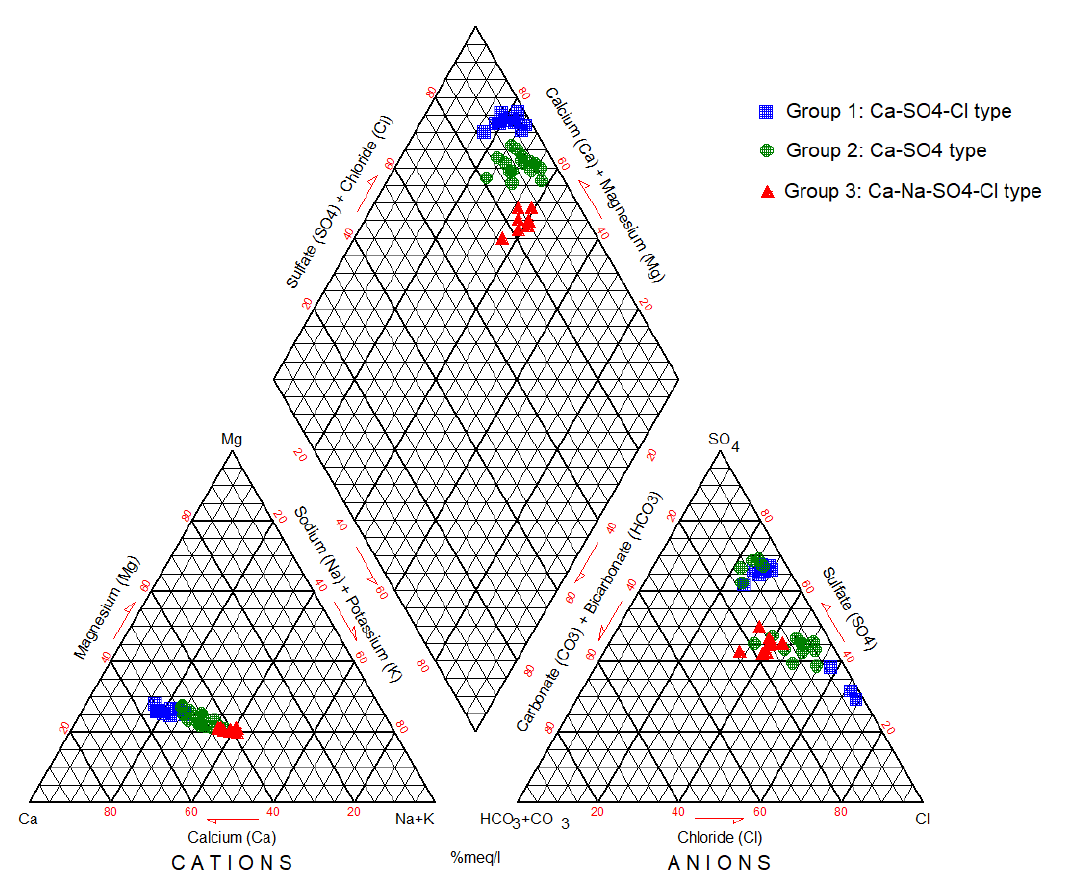
Figure 6. Piper classification diagram with the three hydrochemical groups of groundwater identified from the Wasia aquifer in the Al Kharj area.